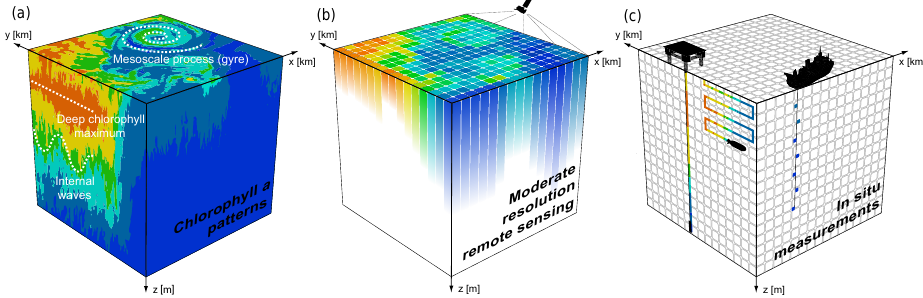
Figure 6. Comparison of how typical chl- a distribution patterns (a) are resolved with moderate-resolution satellite sensors (b) and in situ measurements (c)